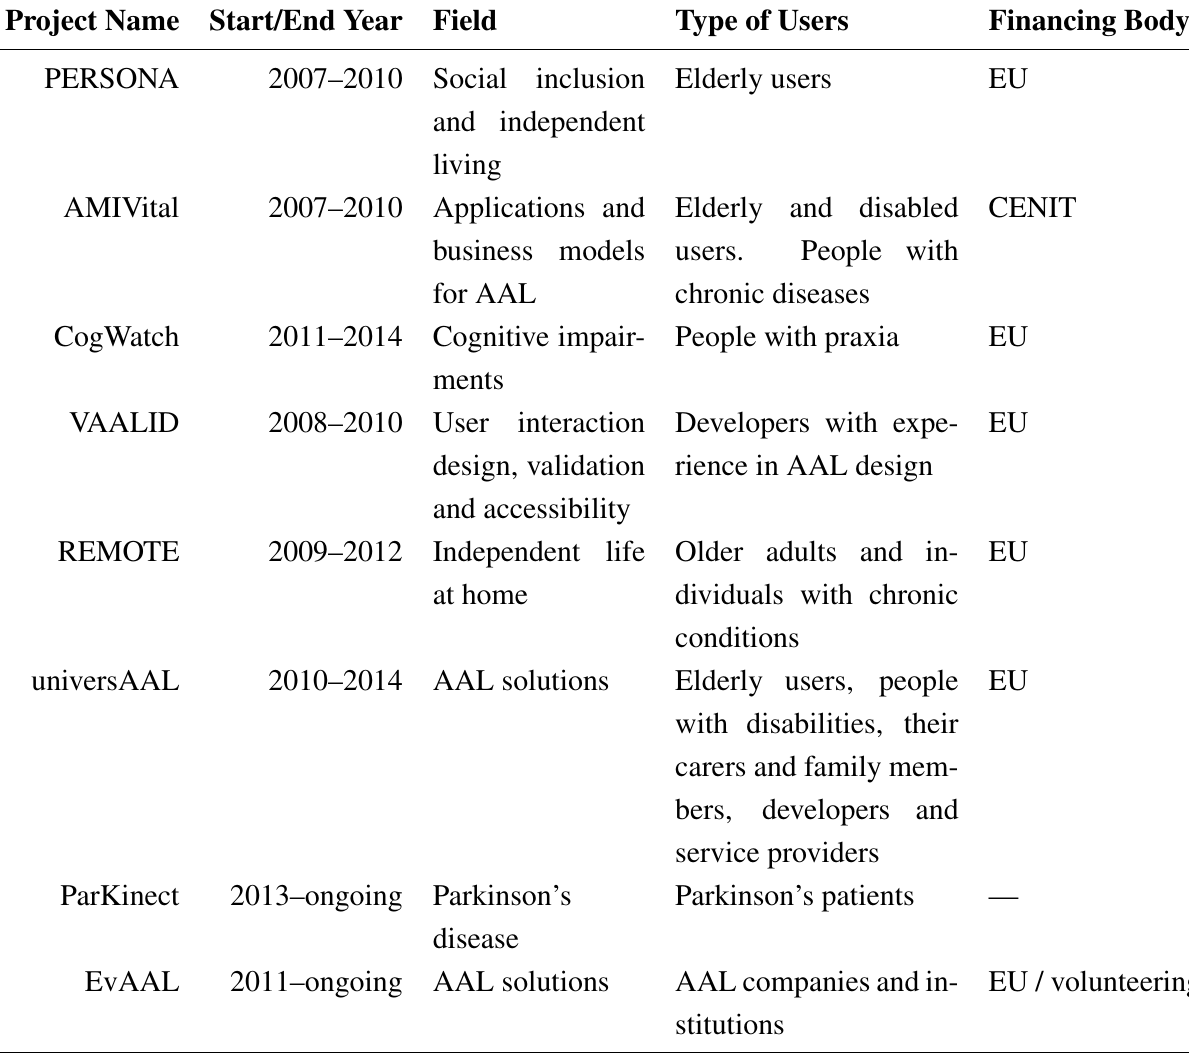
Table 1. Summary of research projects. AAL, ambient assisted